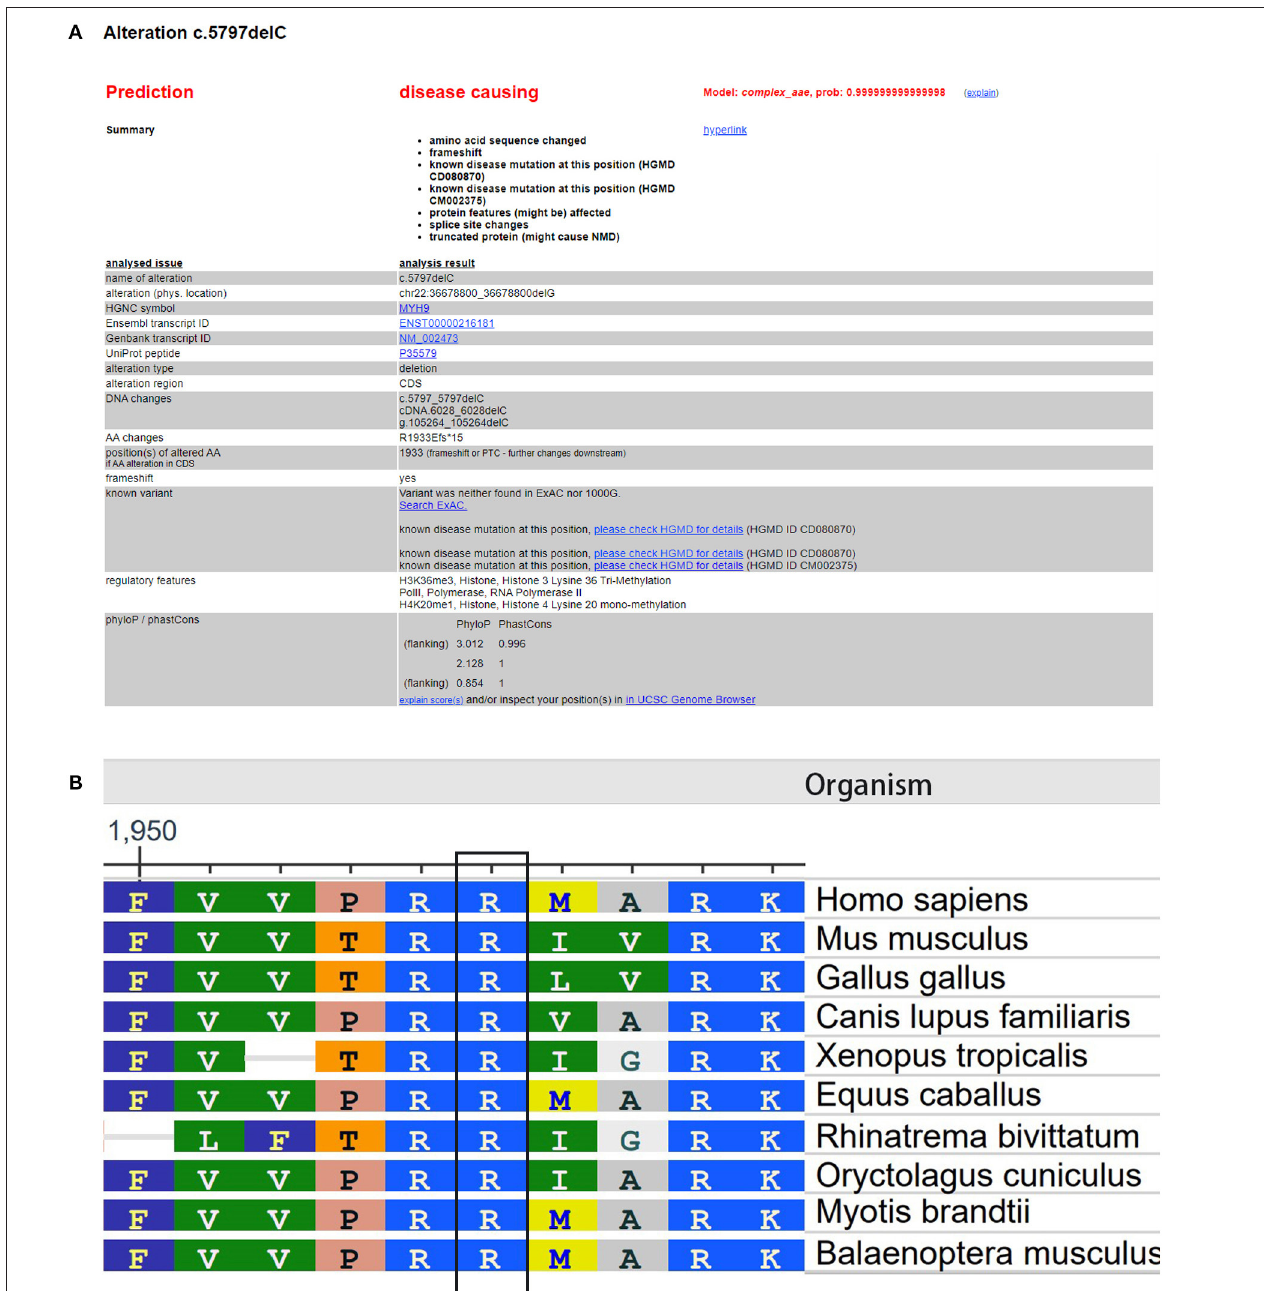
FIGURE 3 | Evaluation of the pathogenic potential of the c.5797delC mutation in MYH9. (A) Web-based software Mutation Taster showed that this mutation was disease causing, and the mutation at this position was reported. (B) Analysis of amino acid conservation based on the NCBI